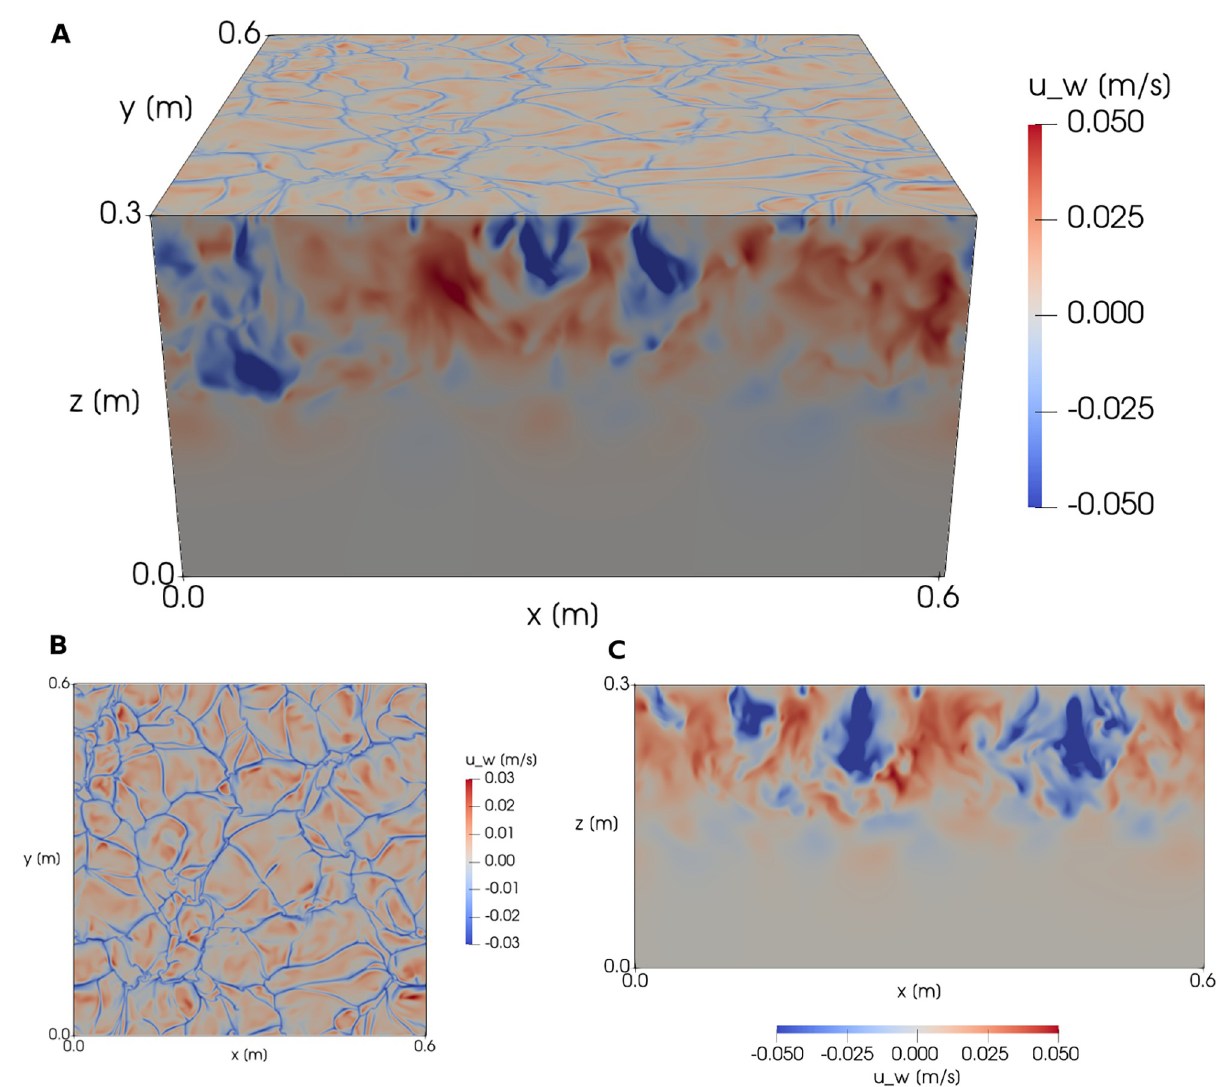
Fig 7. Vertical fluid velocities (in ms − 1 ) at t = 60 s during the SPARKLE DNS. Axes are labelled in units of DNS cell side-length. (a) shows the velocities at the surface and sides of the simulation. (b) is a top-down view of the fluid surface demonstrating rising regions of less dense fluid (red) pushing aside denser, falling fluid (blue). (c) is a side-on cross-section view through the center of the simulation, demonstrating the depth profile of these cooler (blue) and warmer (red) regions.